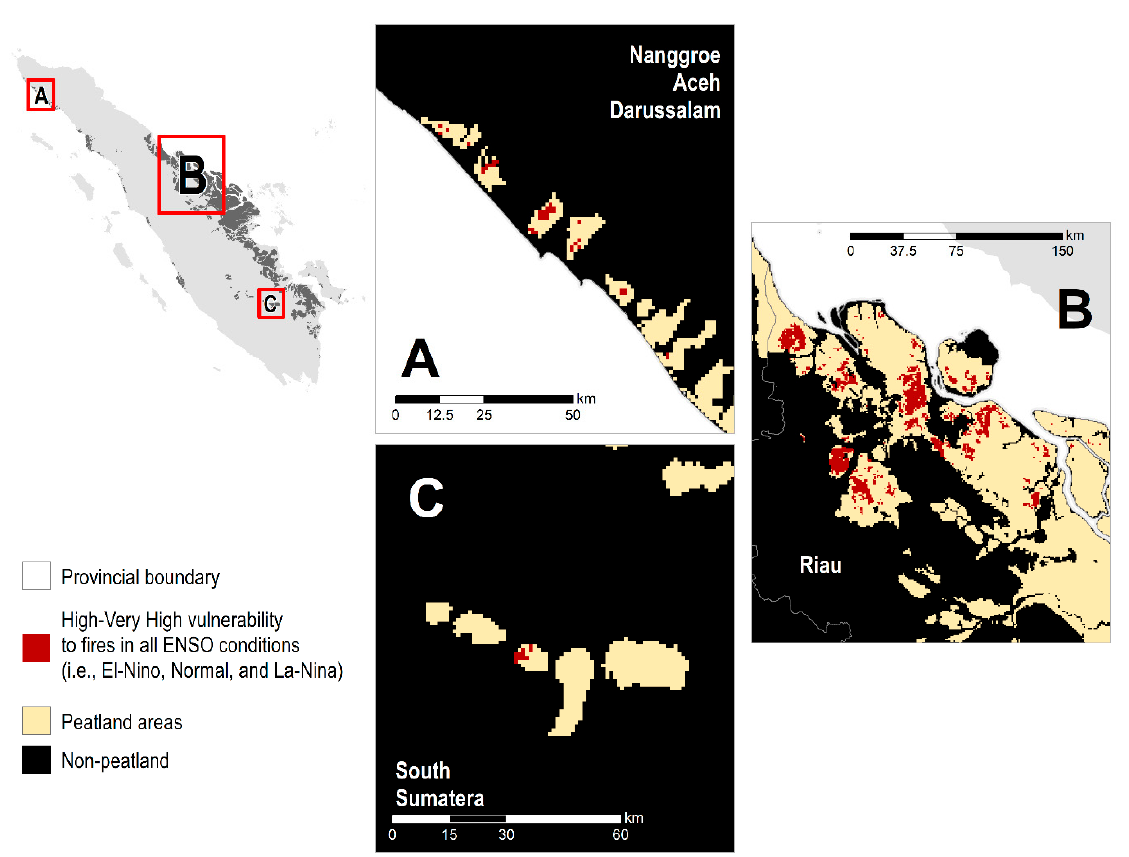
Figure 8. Area with high and very-high vulnerability classes in all ENSO phases, located in Nanggroe Aceh Darussalam Province ( A ), Riau Province ( B ), and South Sumatera Province ( C ).